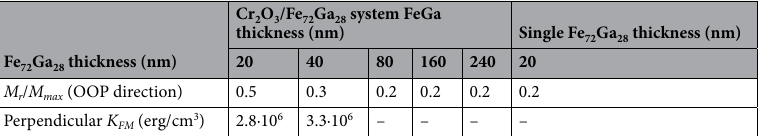
Fe 72 Ga 28 thickness